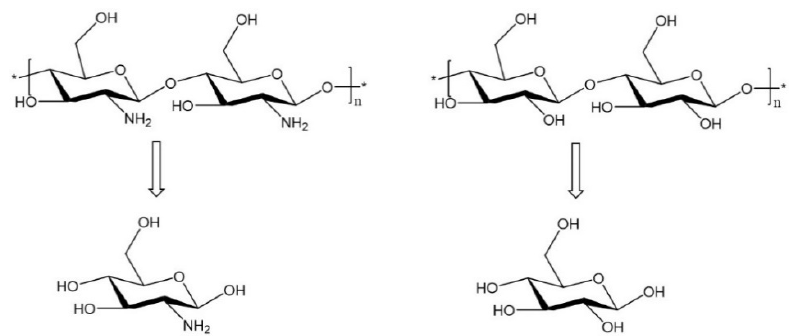
Figure 1. Structures of animal and plant polysaccharides (Left: chitosan; right: cellulose).